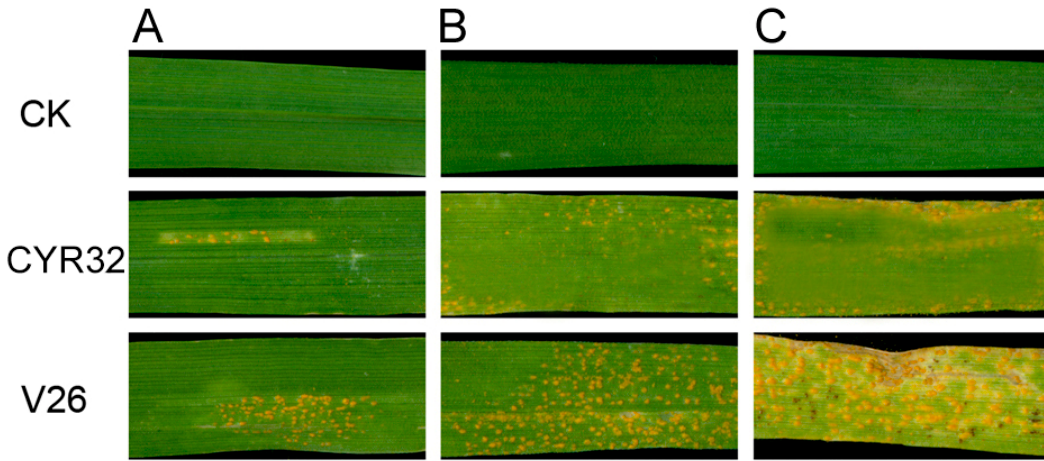
Figure 1. Symptomatology of wheat cultivar Chuanmai42 (CM42) inoculated with CYR32 and V26. A-C represent different day-after inoculation with Pst . CK, un-inoculated wheat leaves. 2.2. Changes in Chlorophyll (Chl) Content, Total Protein Content, and Osmotic Regulators